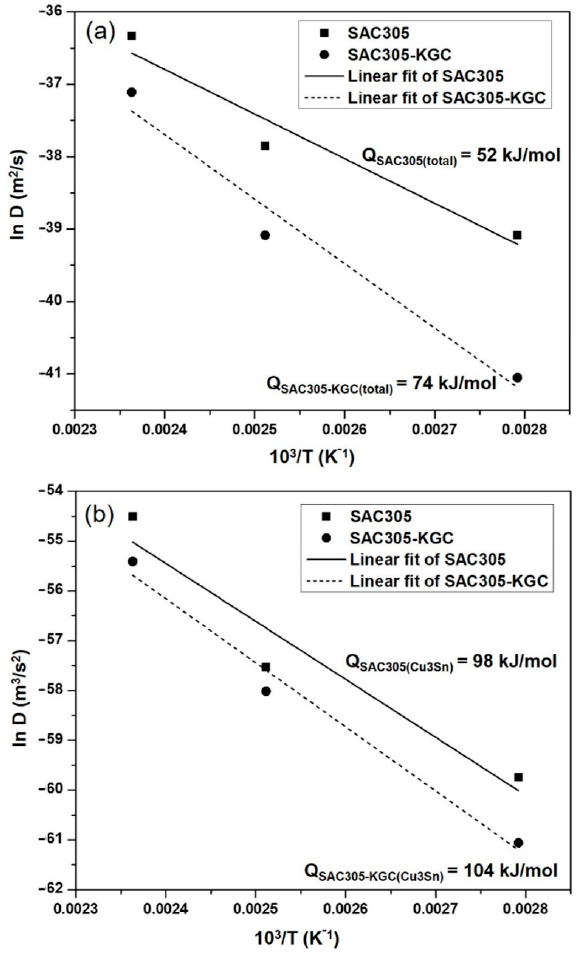
Figure 15. Arrhenius plot of ln D vs. 1/T for ( a ) total interfacial IMC layer and ( b ) Cu 3 Sn layer in SAC305 and SAC305-KGC composite solder.